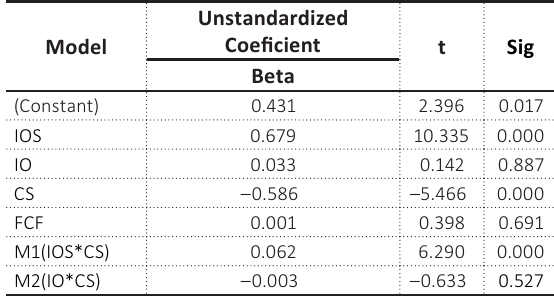
Source: Calculation results with